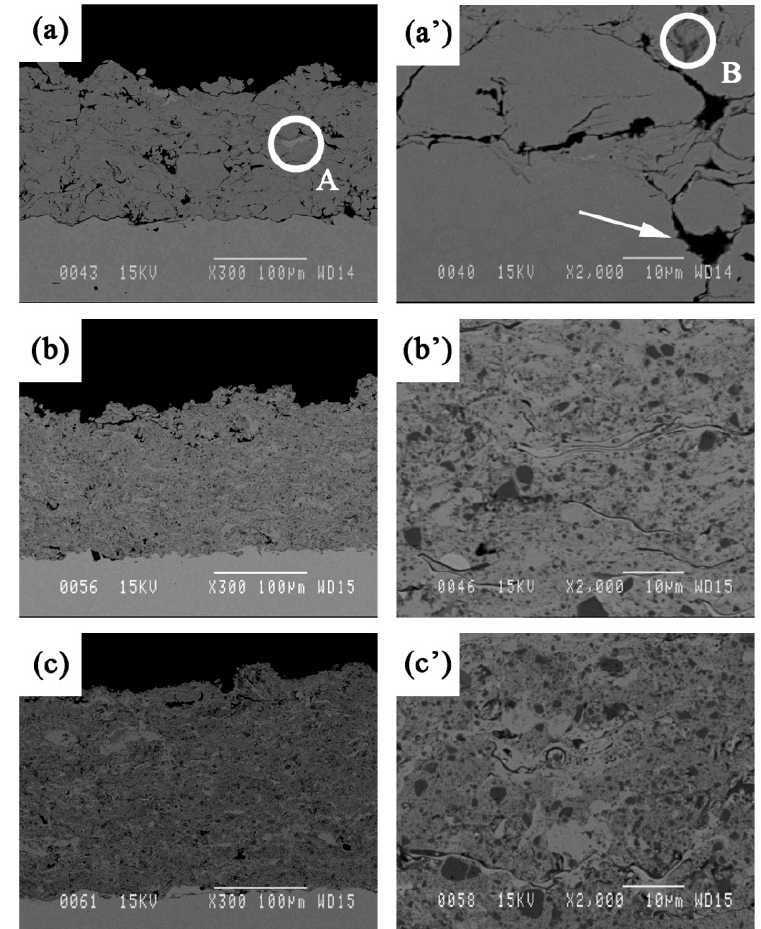
Figure 2. Cross ‐ sectional backscattered SEM images of the unreinforced (0 vol.% TiB 2 ) Fe 3 Al ( a and a’ ), 30 ( b and b’ ) and 50 ( c and c’ ) vol.% TiB 2 coatings. The arrow on a’ indicates a pore.